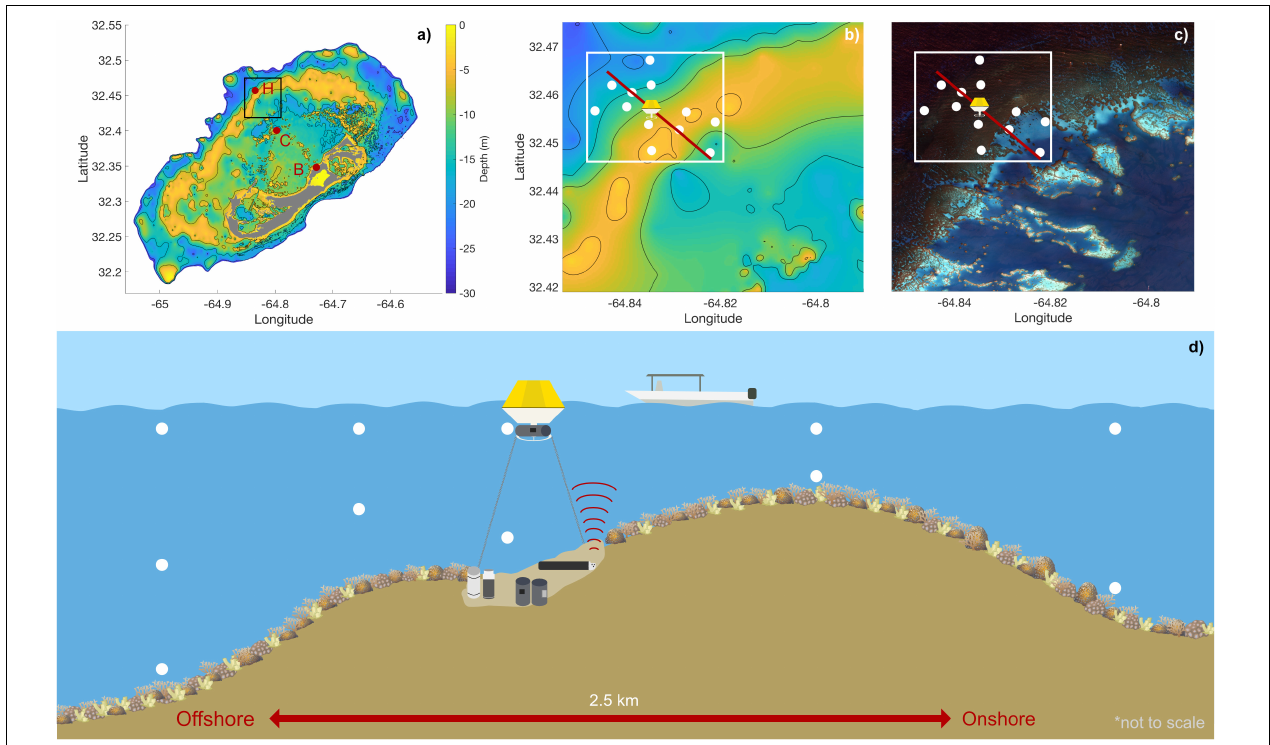
FIGURE 1 | Details of study site: (a) Depth contour map of the Bermuda platform, indicating Hog Reef (H), Crescent Reef (C), and Bailey’s Bay (B) (letters and red circles) with a section of the rim reef including Hog Reef boxed in black (b,c) ; (b) Depth contour map of Hog Reef from black box in (a) with spatial survey locations (white circles), buoy location, onshore-offshore reef transect (red line), and spatial survey area in white (see Figures 5 – 7 ); (c) High-resolution satellite image of Hog Reef, Bermuda processed by Dr. Tyler Cyronak under an imagery grant from the DigitalGlobe Foundation from black box in (a) with spatial survey locations (white circles), buoy location, onshore-offshore reef transect (red line), and spatial survey area in white (see Figures 5 – 7 ); (d) Conceptual diagram of the onshore-offshore transect and sampling scheme with the Hog Reef buoy, 6 autonomous sensors, and boat spatial survey water sampling locations (white circles) on exaggerated reef contour (not to scale). Coral icon images attributed to Tracey Saxby and Diana Kleine, Integration and Application Network, University of Maryland Center for Environmental Science